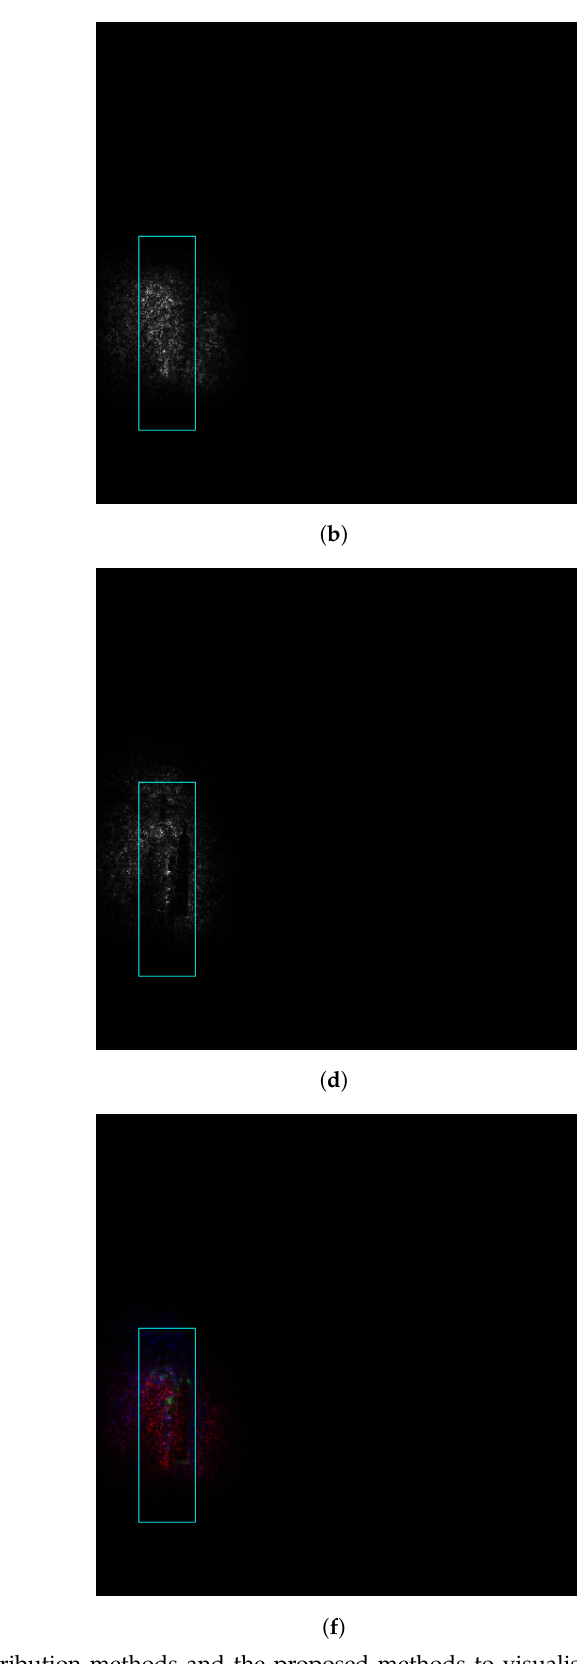
Figure 7. Gradients based attribution methods and the proposed methods to visualise the fire extinguisher prediction using YOLO V3. ( a ) YOLO prediction. ( b ) Gradient. ( c ) GBP. ( d ) IG. ( e ) WS-Grad (proposed). ( f ) Concat-Grad